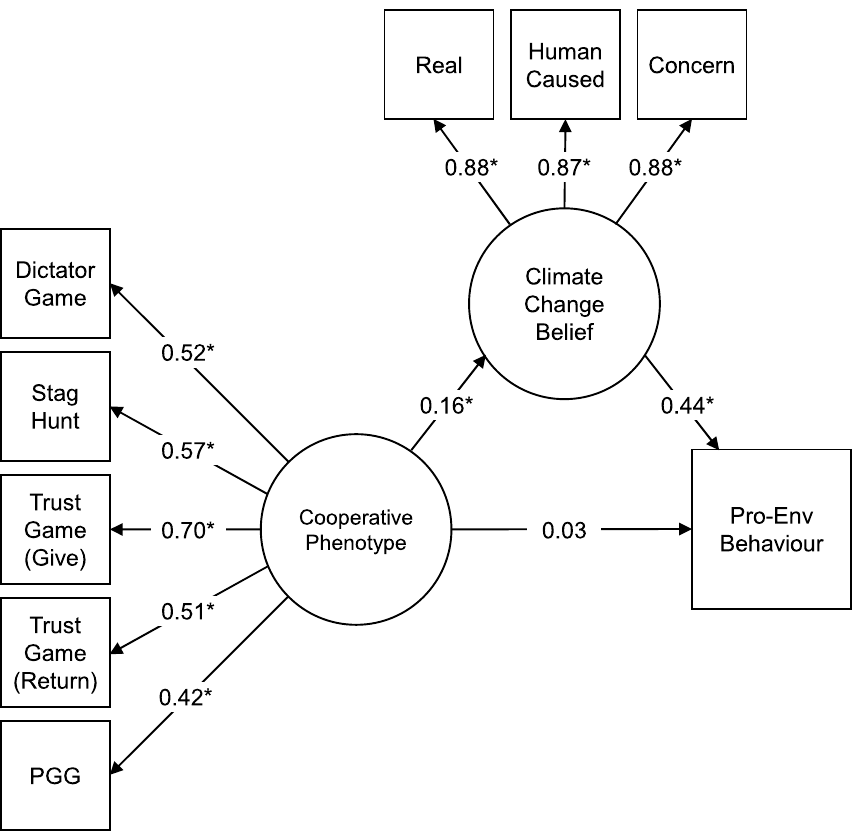
Figure 4. Reversed structural equation mediation model (N = 897). Regressing pro-environmental behaviour on the cooperative phenotype factor, mediated by the climate change belief factor. Note: this visualisation does not include paths from the full model predicting game behaviour from game comprehension. Numbers are standardised parameter estimates; * p <